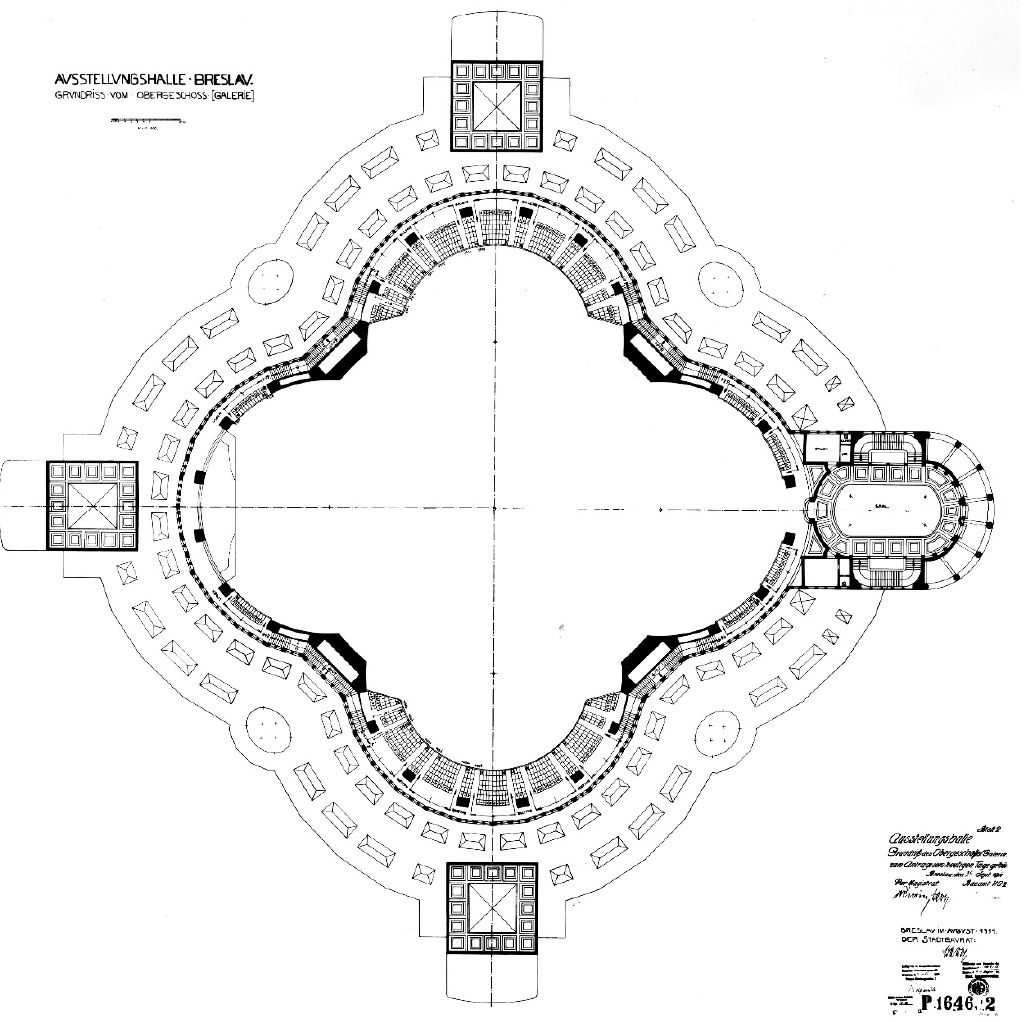
Figure 8. Centennial Hall, plan of second floor and galleries, developed in August 1911 and approved by the Municipality of Wrocław on 25 September 1911 (Wrocław Construction Archive, a branch of the Museum of Architecture in Wrocław).